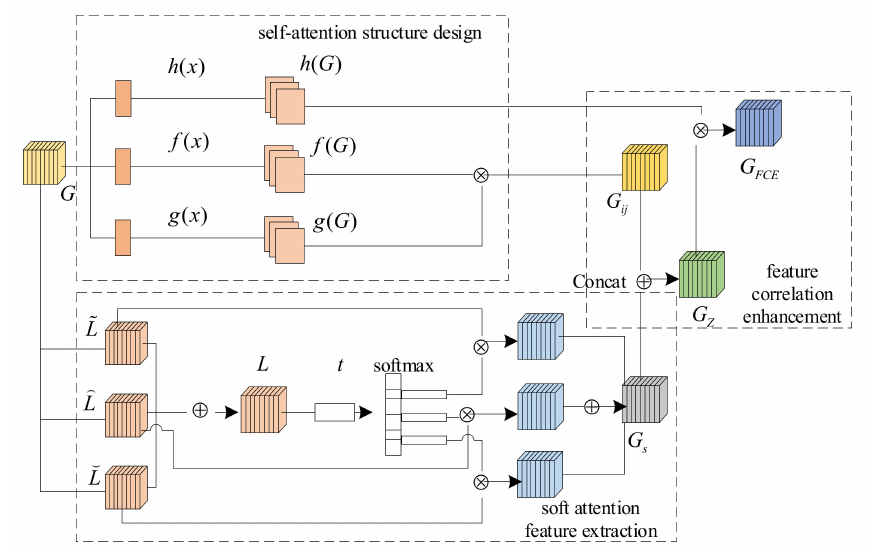
Figure 2. Structure of FCE